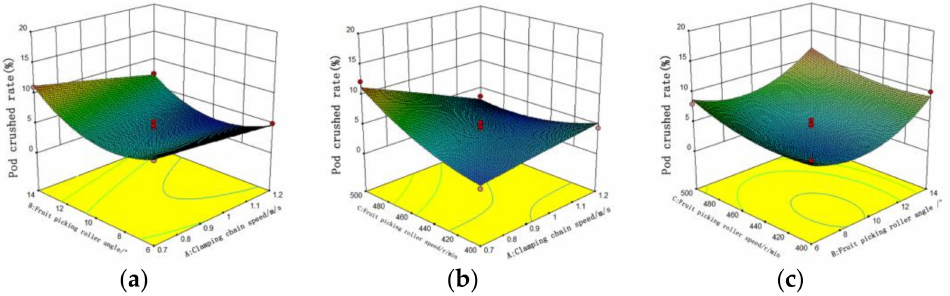
Figure 12. Response surface of the influence of factor interaction on pod crushed rate. ( a ) Interaction between fruit picking roller angle and clamping chain speed; ( b ) Interaction between fruit picking roller speed and clamping chain speed; and ( c ) Interaction between fruit picking roller speed and fruit picking roller